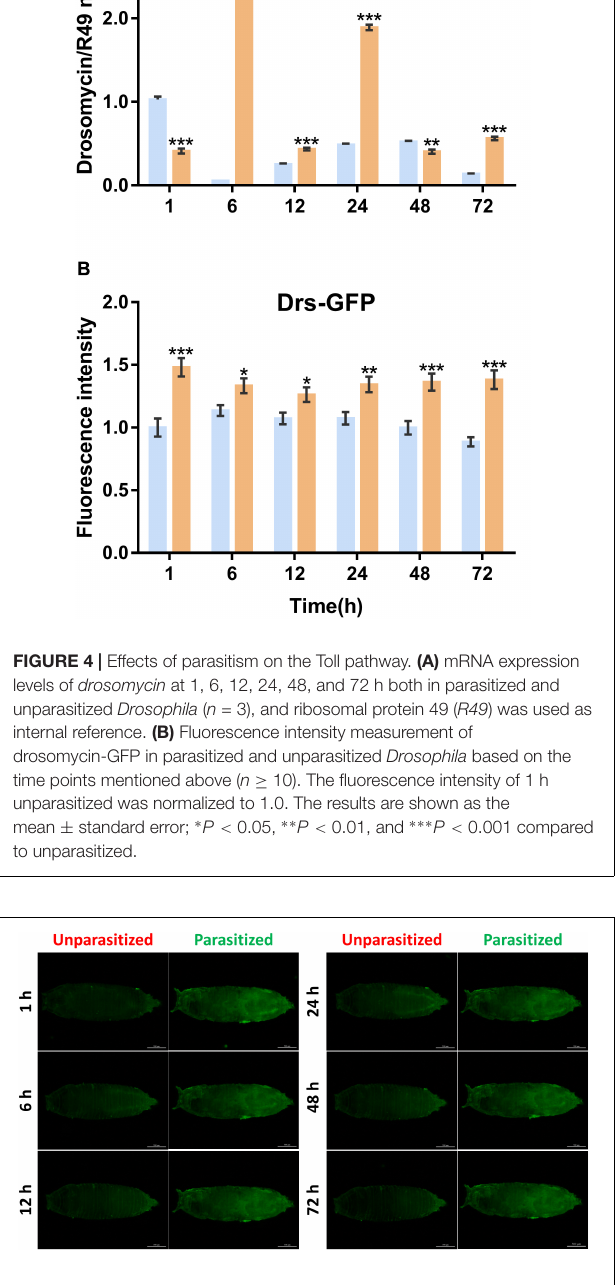
FIGURE 5 | Fluorescence microscopy of unparasitized and parasitized drosomycin-GFP in Drosophila at different times. The green fluorescence was visualized through the cuticle using a florescence microscope.